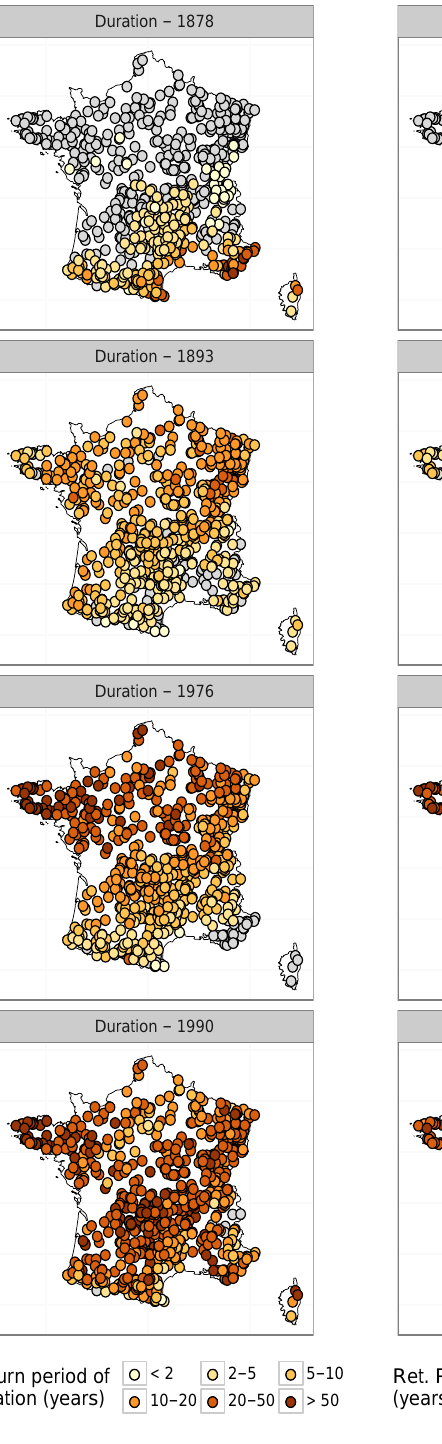
Figure 16. Median value of the return period (in years) for duration (left panels) and severity (middle panels), as well as median start date, as the number of days after the earliest start date (right panels) for the 1878, 1893, 1976, and 1990 extreme low-flow events. The earliest start date is shown in the top-right corner for each event. Filled grey circles represent stations that did not detect the